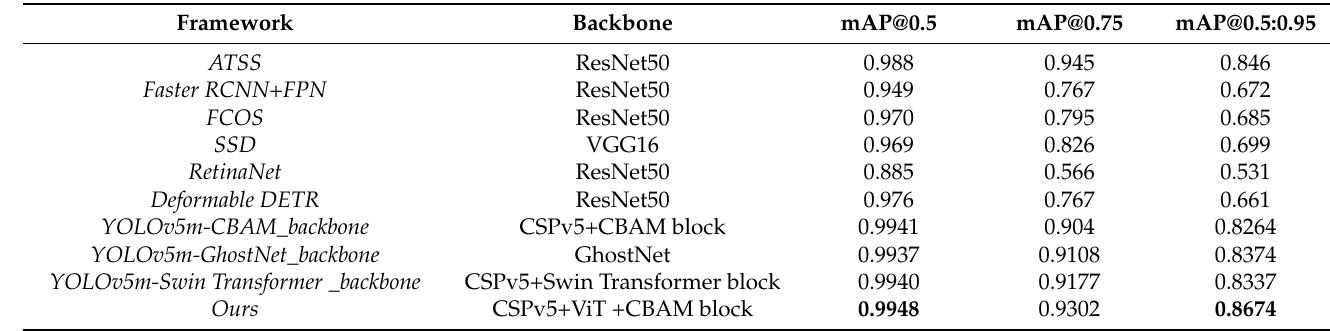
Table 4. Comparison of test performance of various